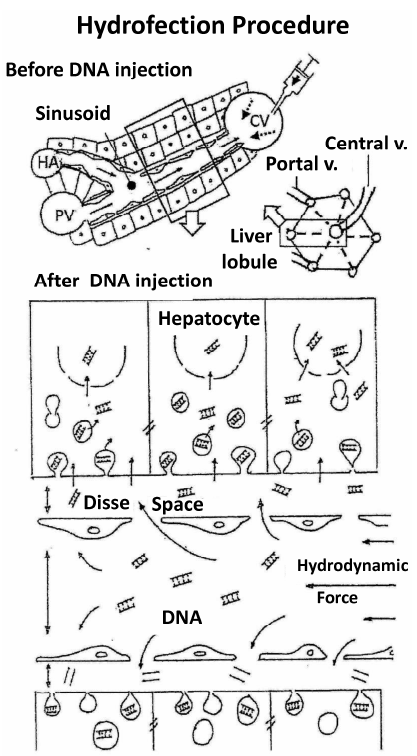
Figure 2. Hydrofection mechanism. The figure shows the mechanism underlying the hydrofection gene transfer to the cells in liver. Upper panel shows a liver lobe unit (right) with its vascular system, which has been enlarged (left) to show the sinusoid vessel detail. Squared area is augmented in lower panel, where the sinusoid vessel organization is showed in detail just after hydrofection. It can be observed that retrovenous injection mediates hydrodynamic force that widens the vessel and virtual Disse space, separates endothelial cells and induces large number of endocytic vesicles on hepatocytes without obvious plasma membrane rupture It suggests that hydrodynamic force mediates DNA delivery to hepatocyte via diffusion process, involving a microfluid uptake process and/or penetration through facilitated permeable sites in the cell membrane. PV: portal vein; CV: Cava vein; HA: hepatic artery.